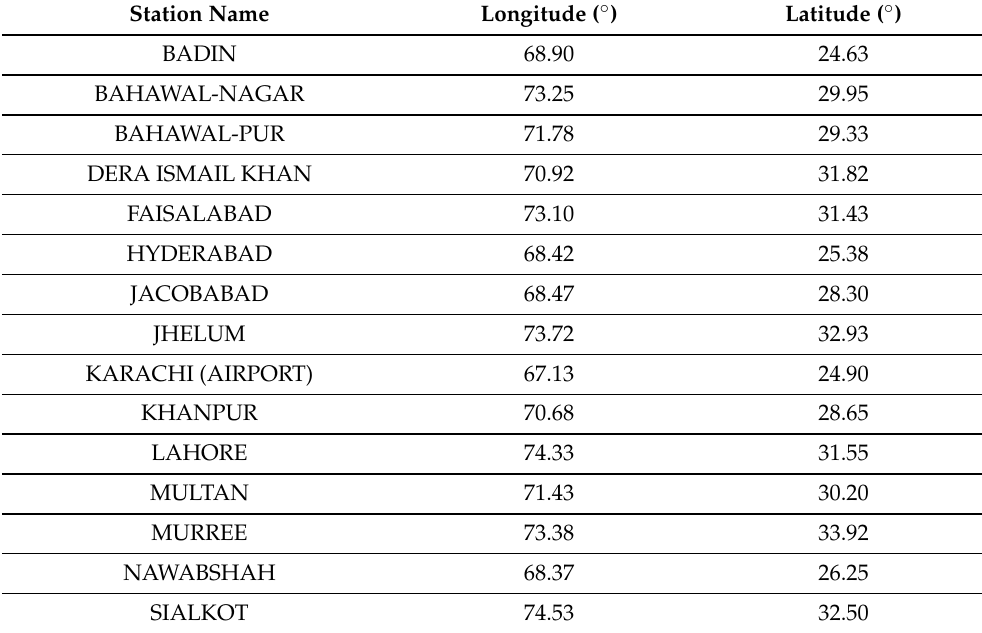
Table 1. Details of the 15 PMD stations used in this study.